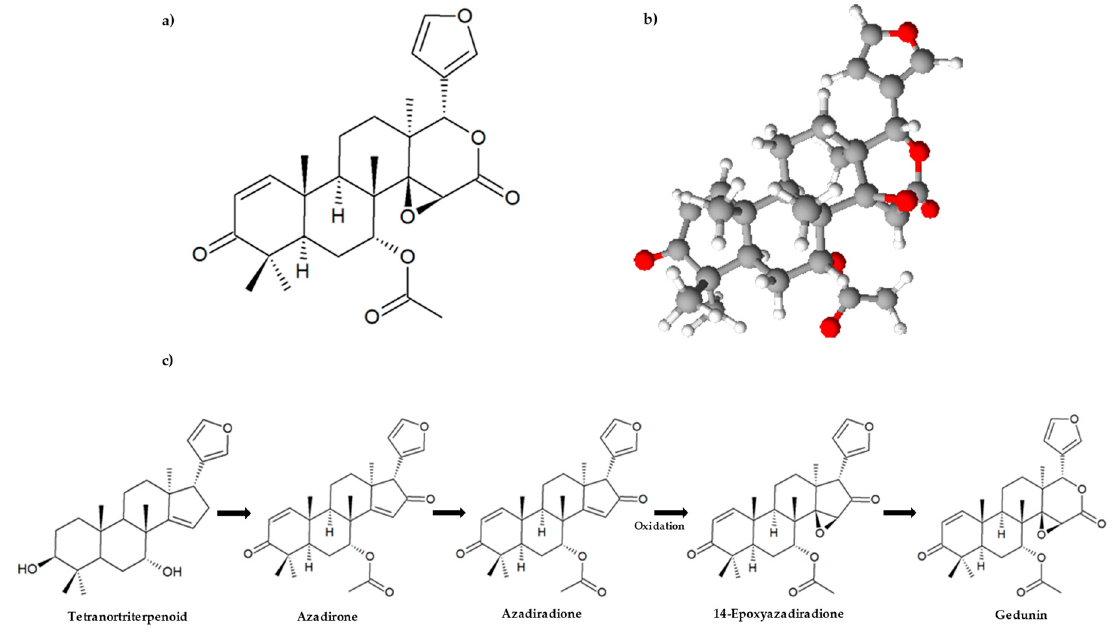
Figure 2. Chemical structure of gedunin: ( a ) Two-dimensional structural formula and ( b ) three-dimensional model; ( c ) Biosynthesis pathway of gedunin (adapted from Narender et al. [12] and Aarthy et al. [15]). ChemSketch software was used to create all chemical